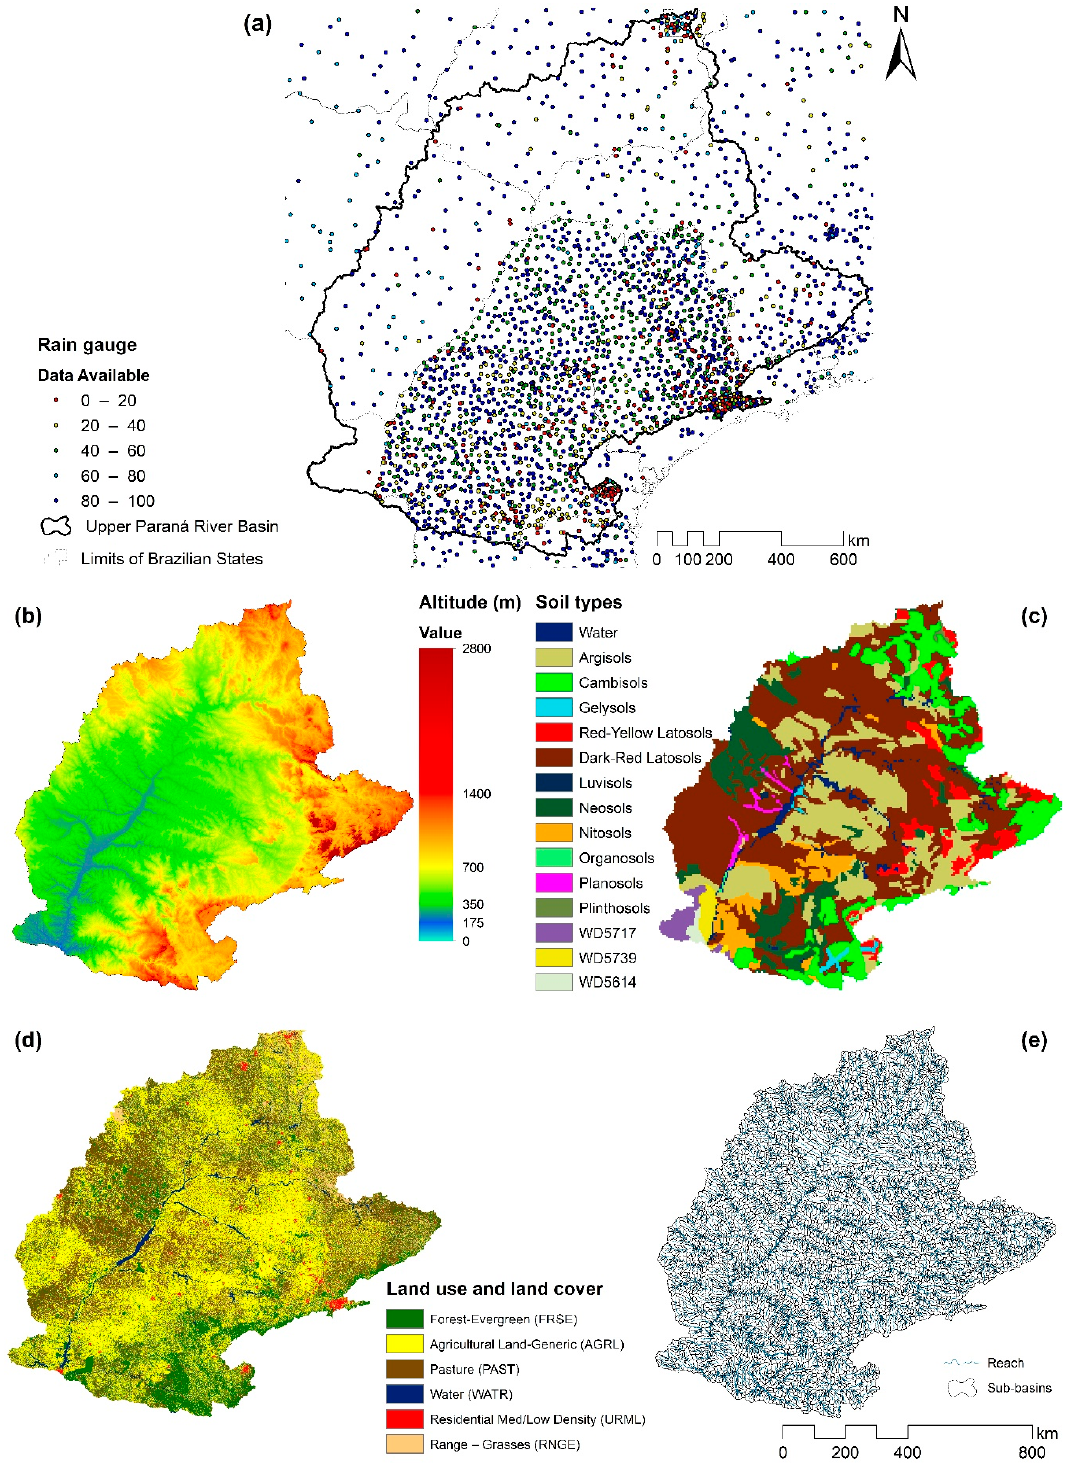
Figure 2. Maps of the ( a ) spatial distribution of precipitation stations, ( b ) topography, ( c ) soil types, ( d ) land use and land cover, and ( e ) discretization and reaches of the UPRB.